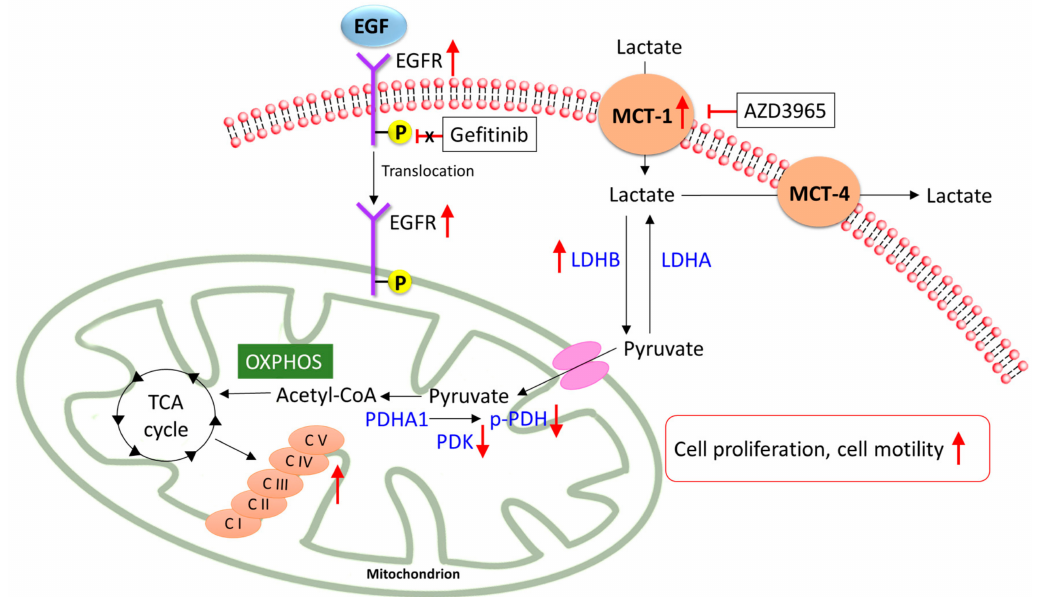
Figure 8. A schematic model of metabolic mechanisms in gefitinib-resistant Ire cells. A proposed model of the metabolic reprogramming that occurs during the development of TKI-resistant non-small cell lung cancer (NSCLC). In gefitinib-resistant NSCLC, EGFR translocated to mitochondria and strengthens mitochondrial oxidative phosphorylation (OXPHOS) capacity and complexes’ activity. Concomitantly, MCT-1, LDHB, and PDHA1 were highly expressed in gefitinib-resistant NSCLC. The inhibition of